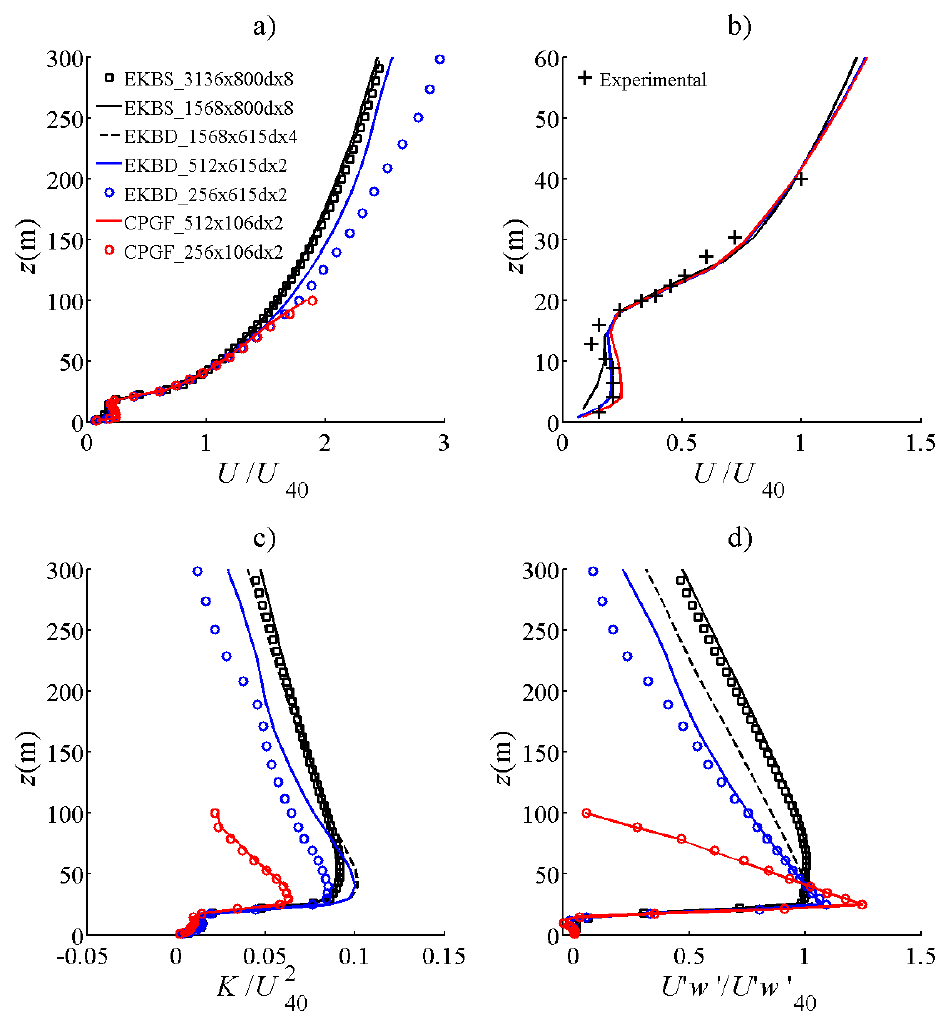
Figure 3. Vertical profiles of normalized turbulent statistics for the sensitivity-analysis simulations: ( a ) Mean streamwise velocity; ( b ) modeled and experimental wind velocities below 60 m; ( c ) turbulent kinetic energy; ( d ) momentum flux. 𝑈 40 and 𝑈′𝑤′ 40 are the horizontal wind velocity and momentum flux at 𝑧 = 40 m.